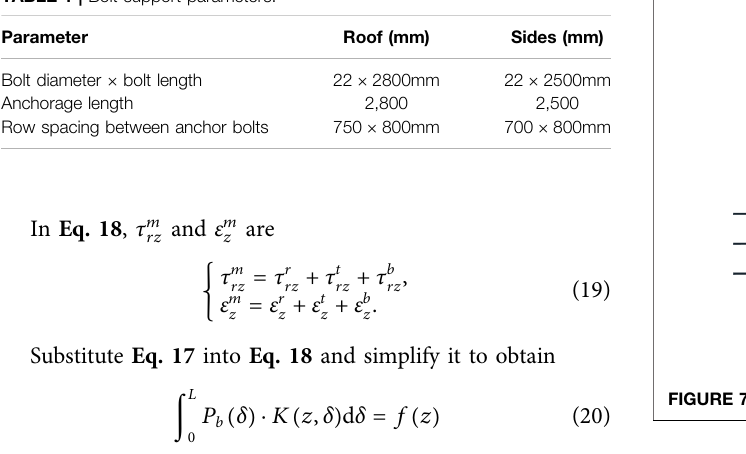
TABLE 1 | Bolt support parameters.